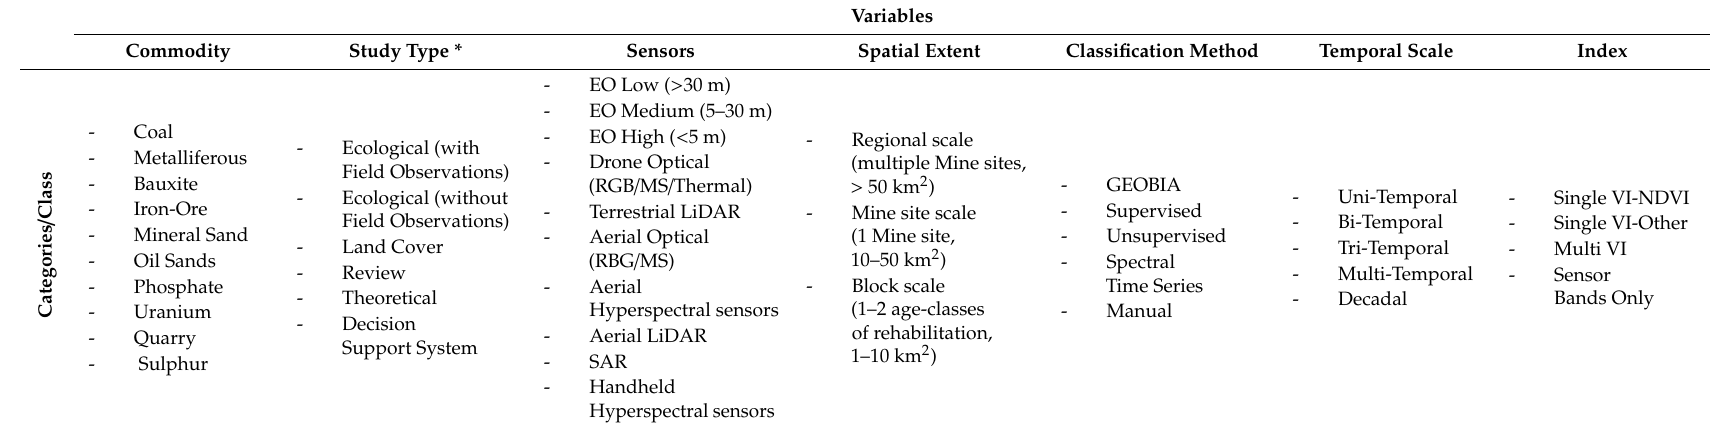
Table 1. Metadata used to categorize each study in the review. Each study was given a class according to the variables below. * Study Type was also classified according to the International Society for Ecological Restoration (SER) ecological recovery wheel attributes (not listed